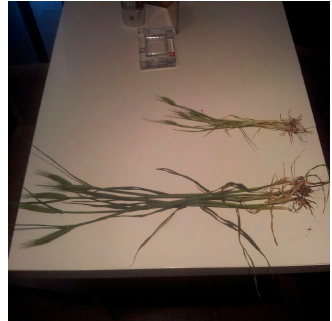
institutes). In the column ‘Remarks’ the results show the efficacy against abiotic stress (acidic and saline soil), biotic stress (decreased infection rate) and on quality, e.g., significantly higher brix, TSS, lycopene and vitamin C content (tomato), protein content (wheat) and fruit firmness (eggplant).